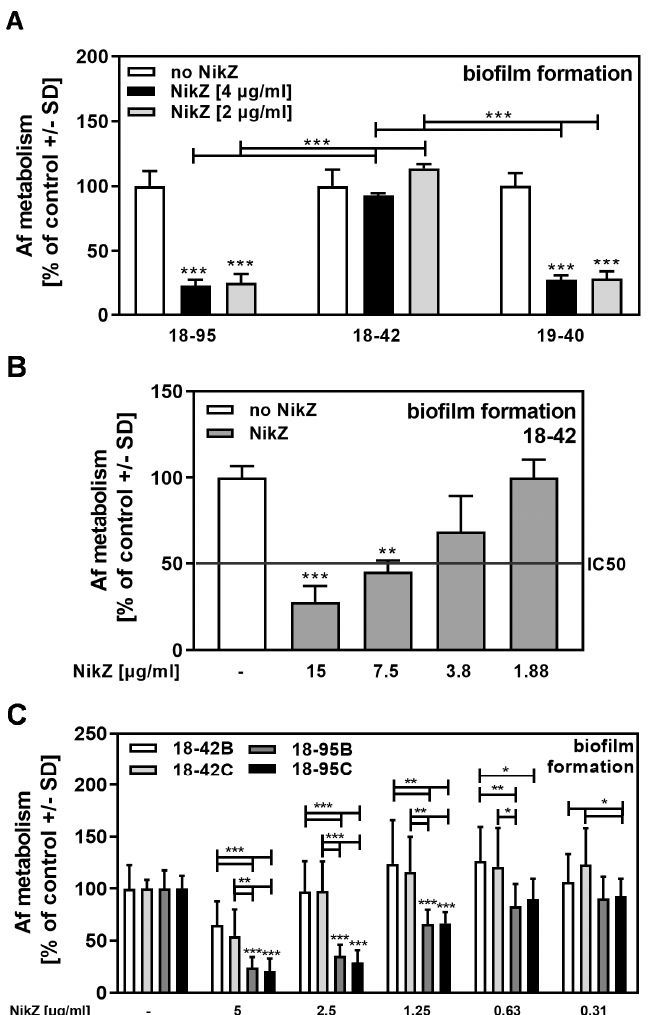
Figure 3. Infected Af293 is more sensitive to NikZ than virus-free Af293. ( A ) Infected (18–95, 19–40) or virus-free (18–42) Aspergillus -forming biofilm was incubated with NikZ (2 or 4 µ g/mL) at 37 ◦ C for 16 h. Fungal metabolism was measured by XTT assay. Metabolism in the presence of RPMI alone (white bars for each strain) was regarded as 100%. Comparisons: No NikZ (white bars) vs. NikZ (black and grey bars) for each strain. Other comparisons are indicated by the ends of the brackets. Statistical analysis (n = 4): Unpaired t -test, three asterisks = p ≤ 0.001. Only significant differences are indicated. ( B ) Strains 18–42 forming biofilm were incubated with NikZ (15 to 0.06 µ g/mL) at 37 ◦